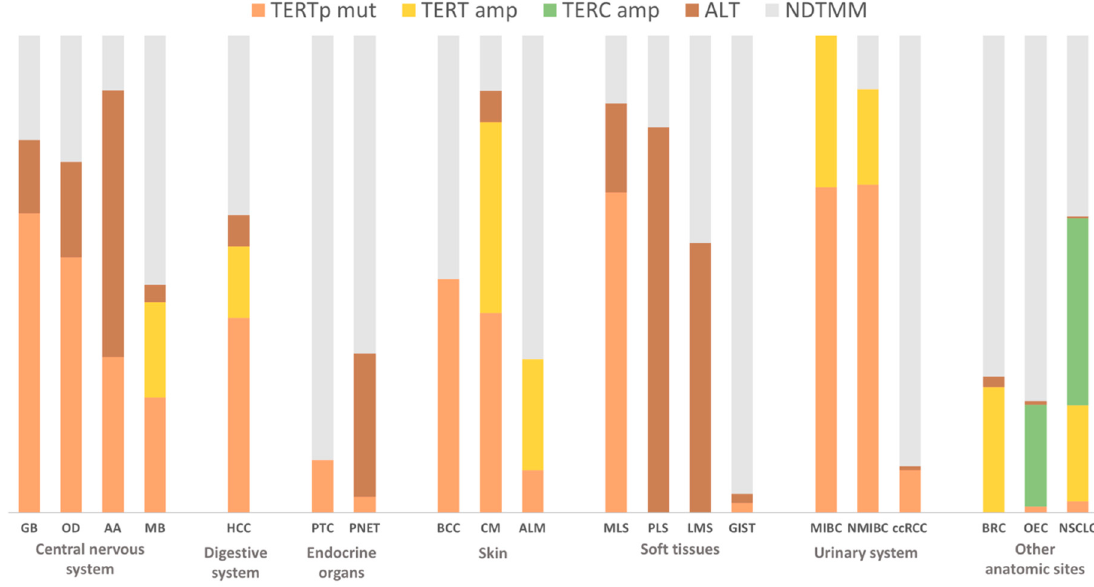
Figure 2. Frequency of telomere maintenance mechanisms in tumours by organ/anatomical site. The